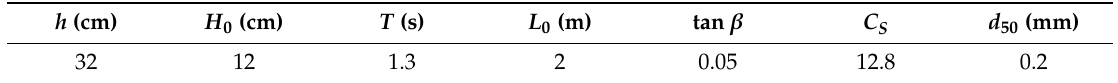
Table 2. Experimental wave